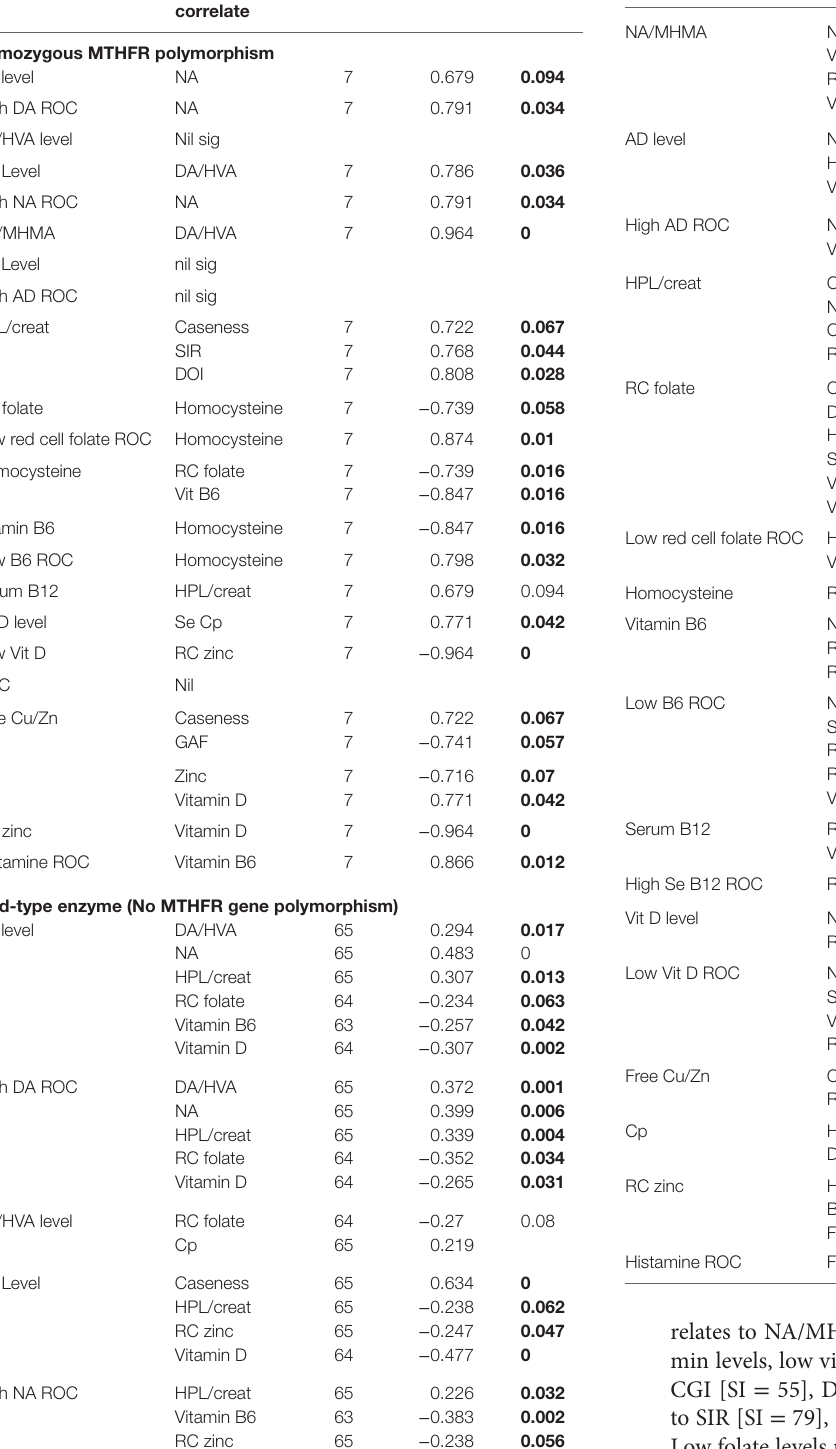
TaBle 8 | continuedTaBle 8 | MThFr 667 split-sample correlates for psychosis biochemistry